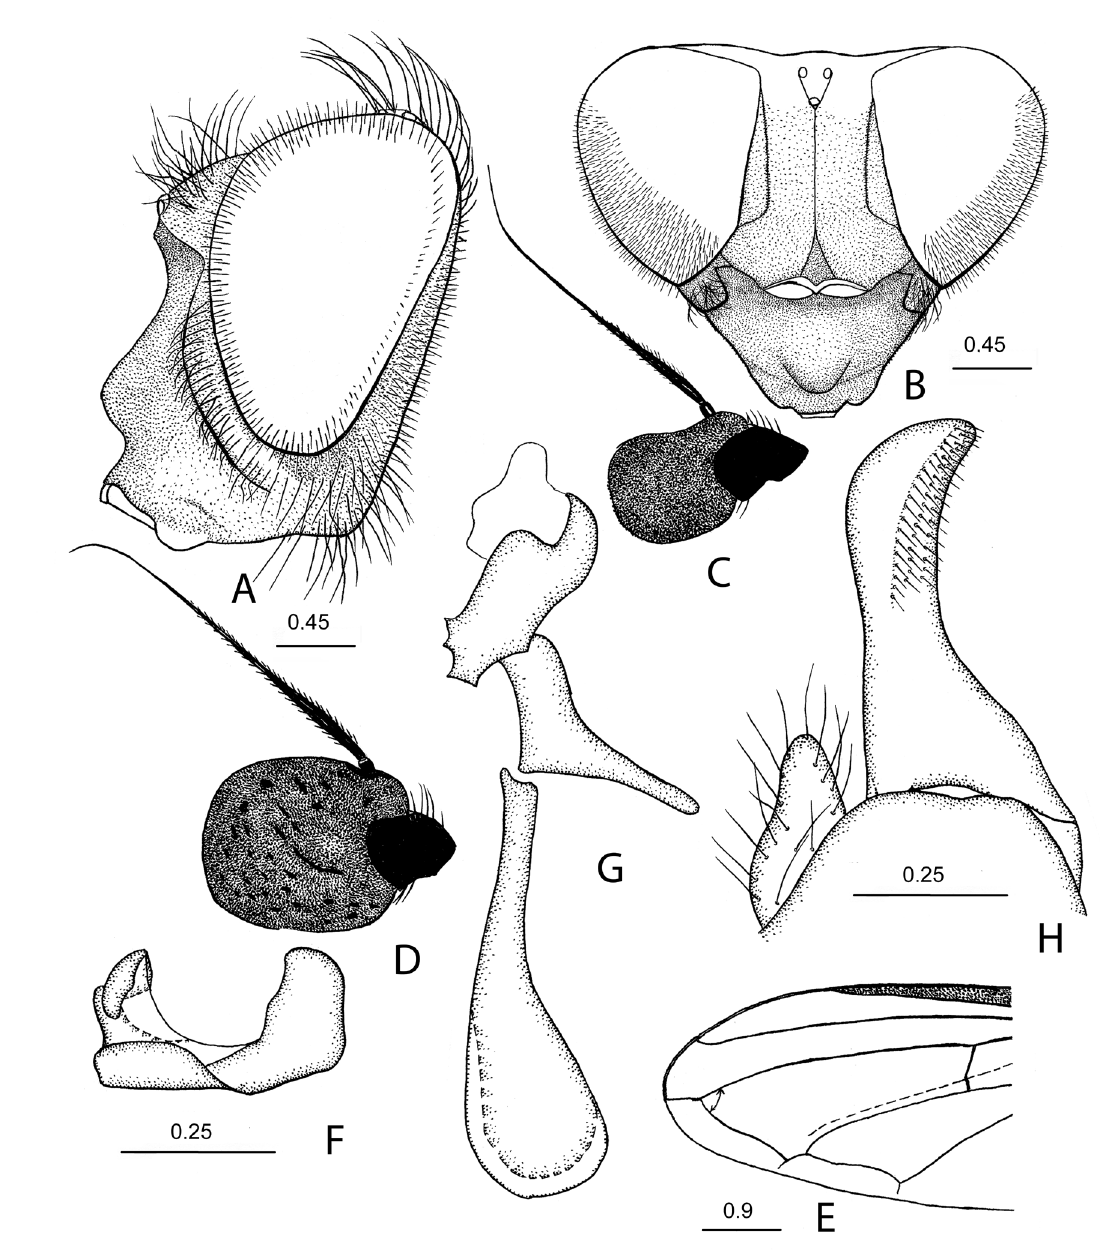
Fig. 43. Cheilosia ( Taeniochilosia ) nepalensis sp. nov.; A, C, E–H = holotype, ♂ (CNC), B, D = paratype, ♀ (CNC). A . Head, lateral view. B . Head, dorsal view. C–D . Antenna, lateral view of pedicel and basoflagellomere. E . Tip of wing. F . Superior lobes of hypandrium, lateral view. G . Aedeagus and aedeagal apodeme, lateral view. H . Surstylus and gonocercus, lateral view. Scale bars indicated in